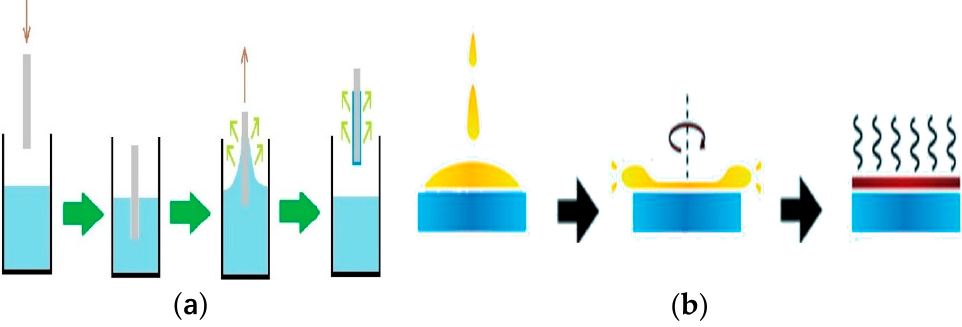
Figure 14. Dip-coating ( a ) and spin-coating ( b ) of TiO 2 photocatalyst on an inert support. Reproduced from work in [155,160]. Copyright 2017 Elsevier Ltd., 2016 Elsevier B.V.